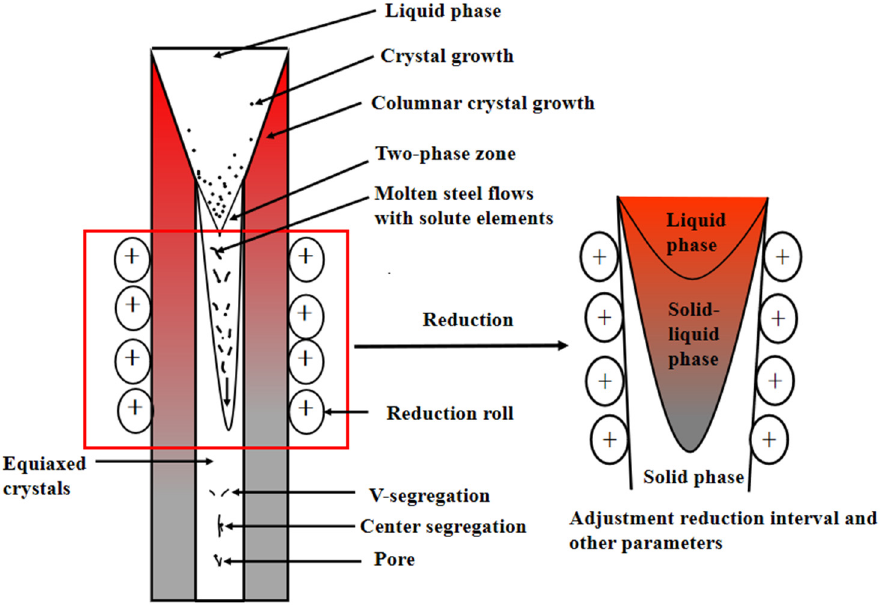
Figure 1. The principle of reduction technology